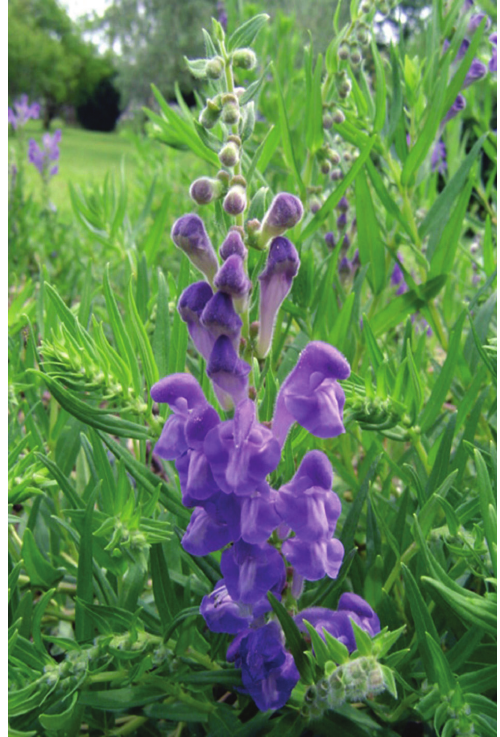
Figure 5. Scutellaria baicalensis Georgi aerial